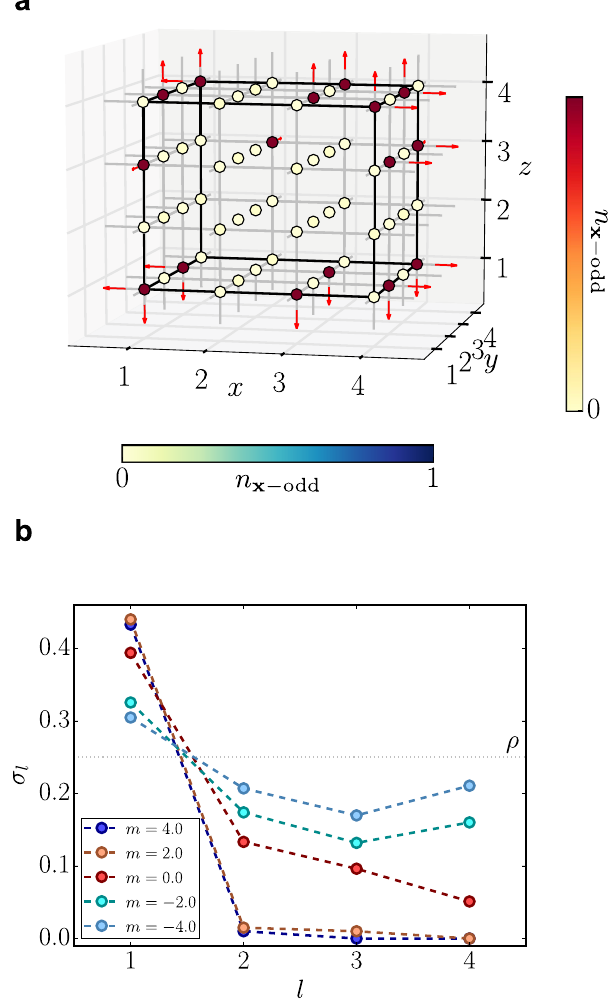
Fig. 5 Finite density analysis. a Ground state con fi guration for m = 4.0 at fi nite charge density ρ = Q / L = 1/4. The system is in the global symmetry sector with Q = 16 positive charges on the lattice with linear size L = 4. b Surface charge density σ l on a cube whose faces are at distance l from the boundaries of the lattice with linear size L = 8. The system is in the global symmetry sector with Q = 128 positive charges ( fi nite density ρ =